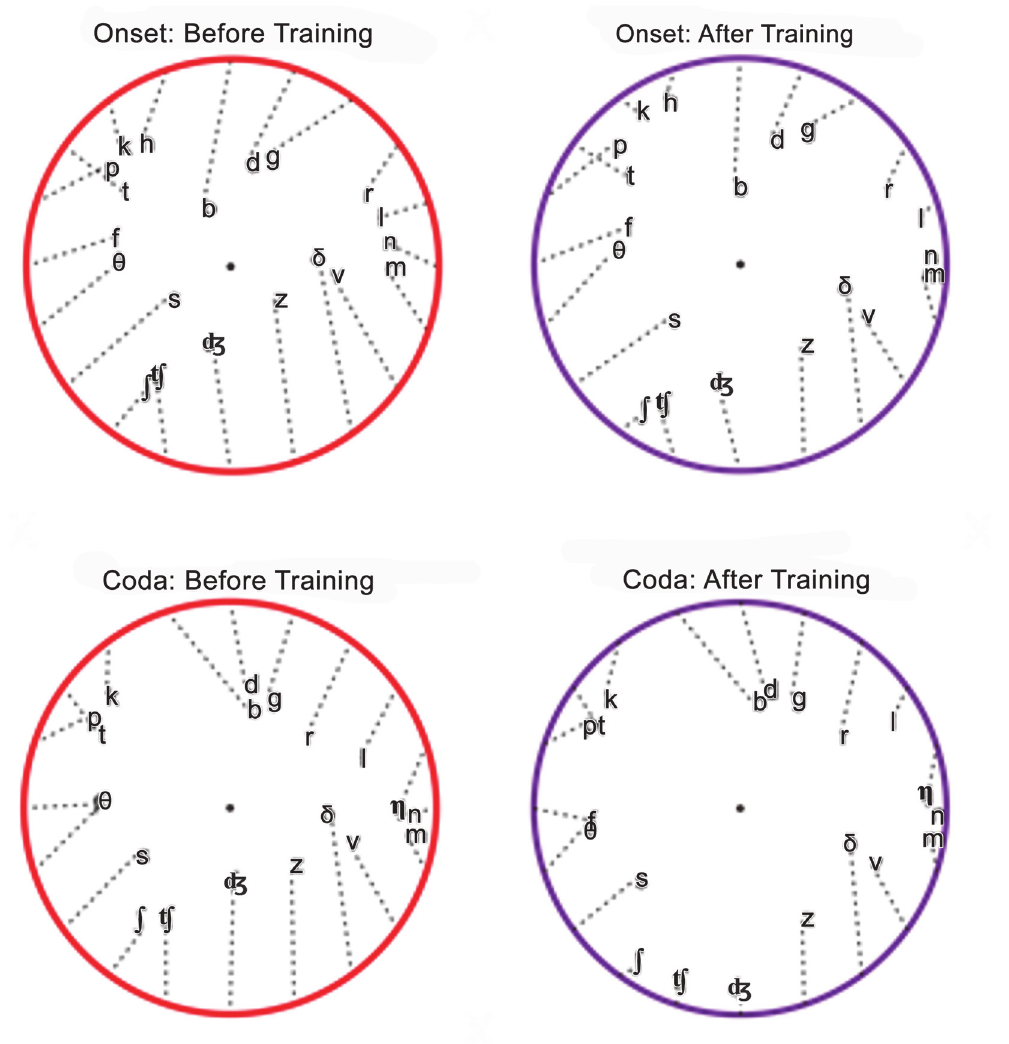
Fig 9. Barycentric consonant confusions circles before (left) and after (right) training. The incidence of consonant confusions is reflected in the distance between consonant pairs.